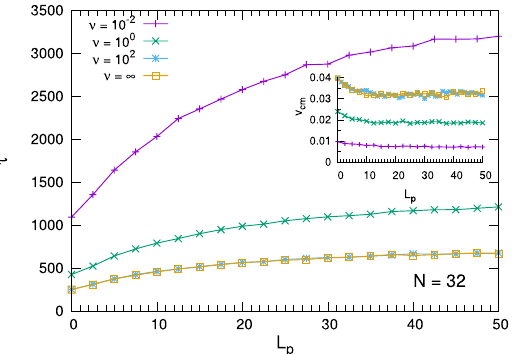
Figure 9. Translocation time and center of mass velocity (inset) as a function of the persistence length L p for the cases of constant applied force ( ν = ∞ in the label) and at different values of the motor activation rate ν = 10 − 2 , 1, 10 2 .